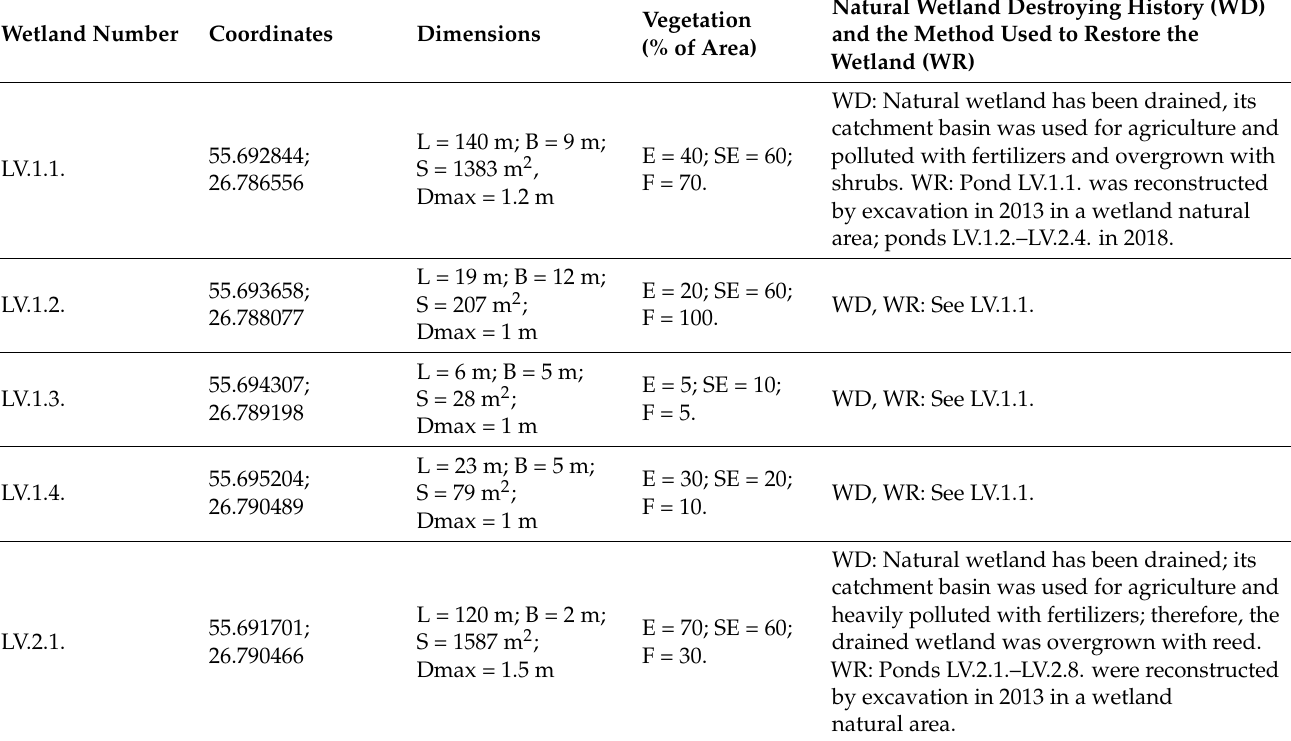
Table 1. The study wetlands of Silene Nature Park with dimensions (L—length, B—width, S—surface, and Dmax—maximum depth), vegetation (E—emergent, SE—submerged, and F—floating), % of area (depending on water level in a particular year or season), and wetland history and restoration (natural wetland destroying history (WD), and the method used for wetland restoration